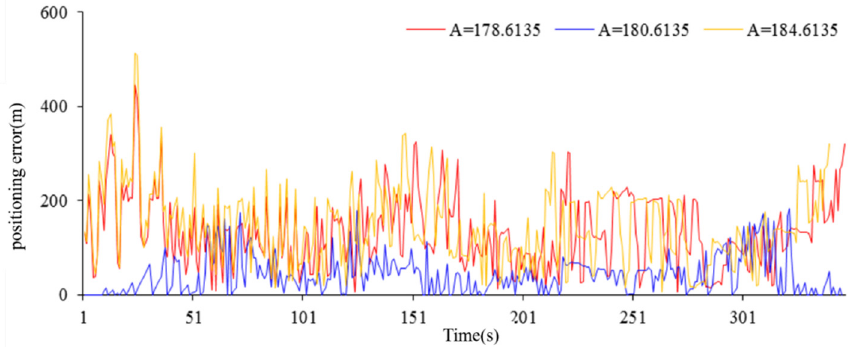
Figure 15. Different environmental indicators impact the fusion of positioning error.